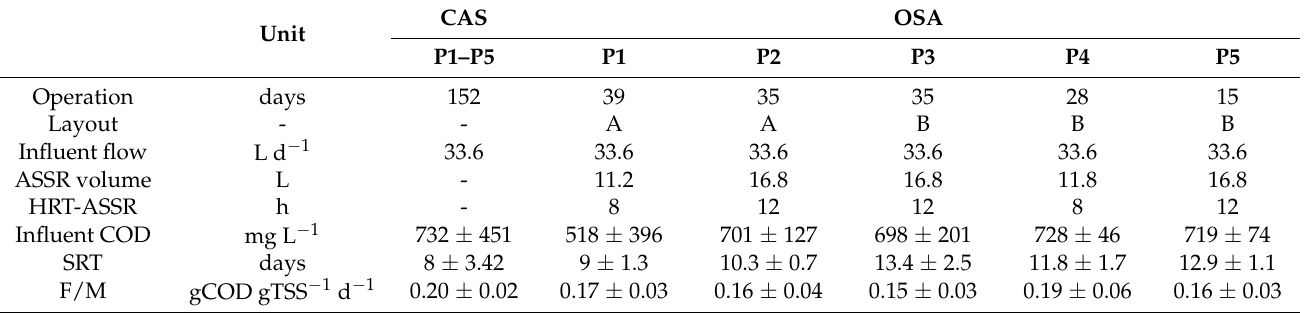
Table 1. Main operating conditions of CAS and OSA during the